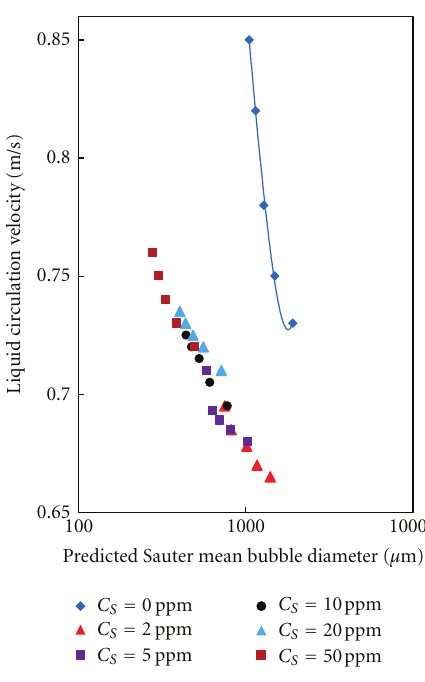
Figure 14: E ff ect of Bubble size on liquid circulation velocity at di ff erent surfactant concentrations ( U G = 0 . 008 ms − 1 , W L /W G =